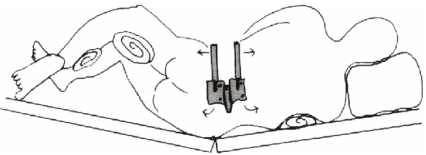
Figure 4: Drawing picture showed the reverse jack-knife position of the patient with distraction of retractor blade pins for loosening the MIS-OLIF PEEK cage form the vertebral